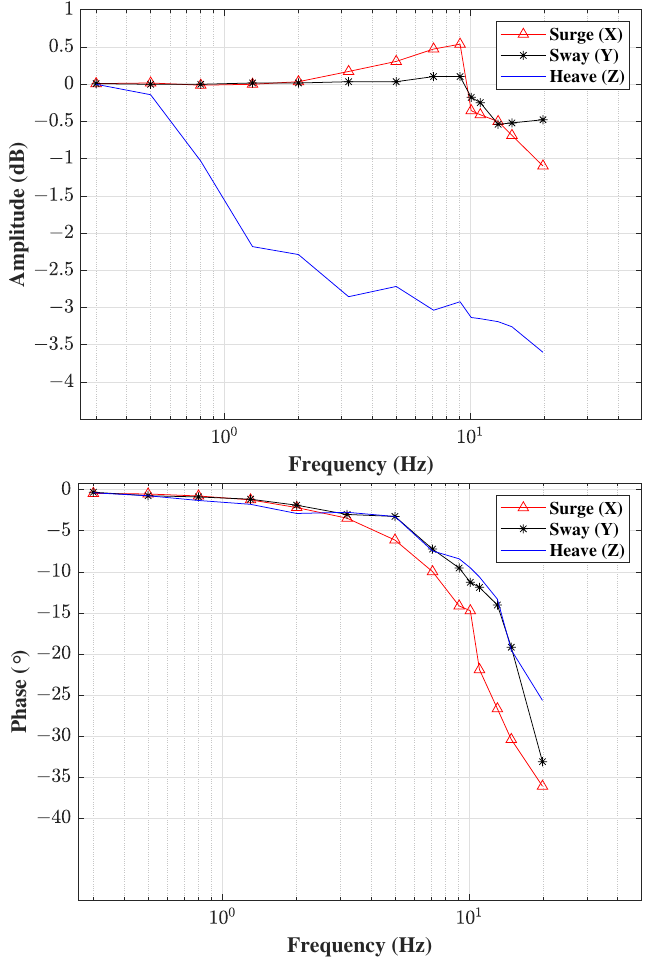
Figure 8. The Bode plot for a translational describing function under TSMC on Cartesian